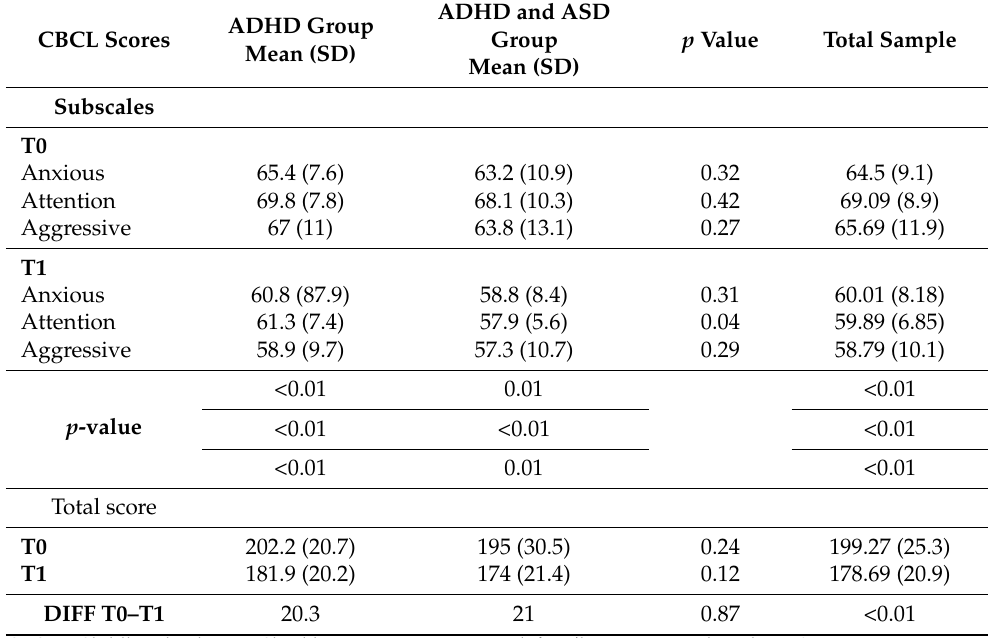
Table 4. Change in CBCL-AAA subscale scores and total scores over 3 months MPH treatment in the two